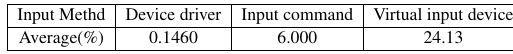
Table 5. top command results